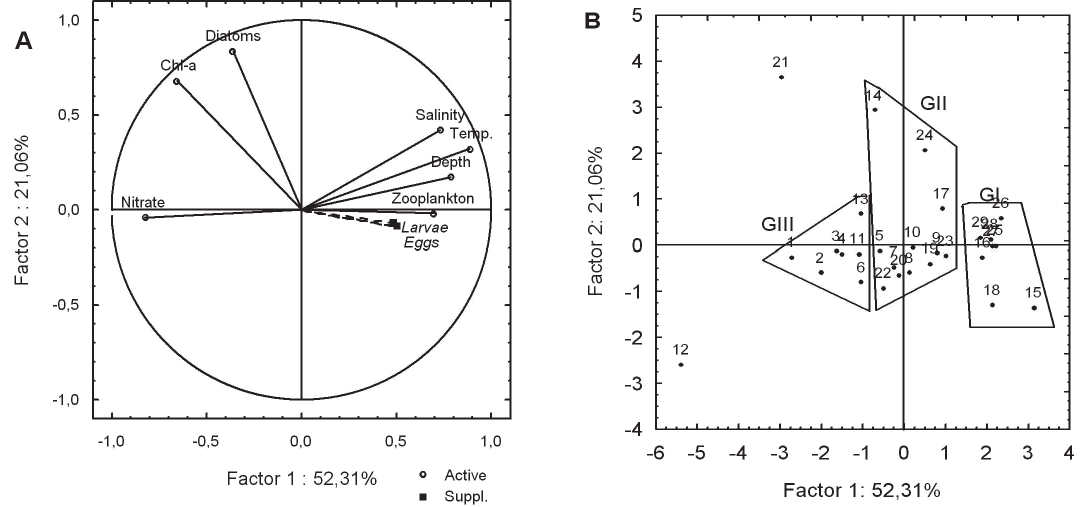
Fig. 10. – Pca of environmental parameters with supplement variables: egg and larval abundances. a: correlation circle of variables; b: projections of stations in the factorial